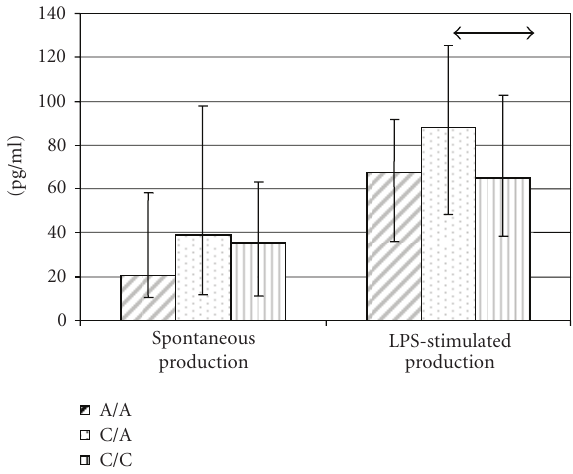
Figure 2: E ff ect of polymorphic variants in the promoter region of the IL-18 gene at the − 607 A → C position on IL-18 production by PBMC (data are represented as median and 25 and 75 percentiles) = 0 . ( ↔ p Mann-Uitni